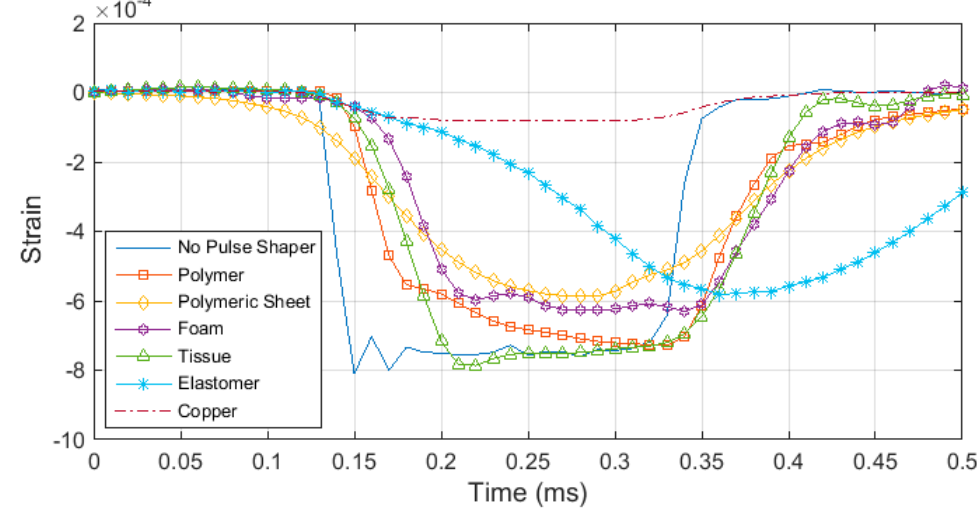
Figure 8. A comparison of pulse profiles generated by different kind of material as the pulse shaper.